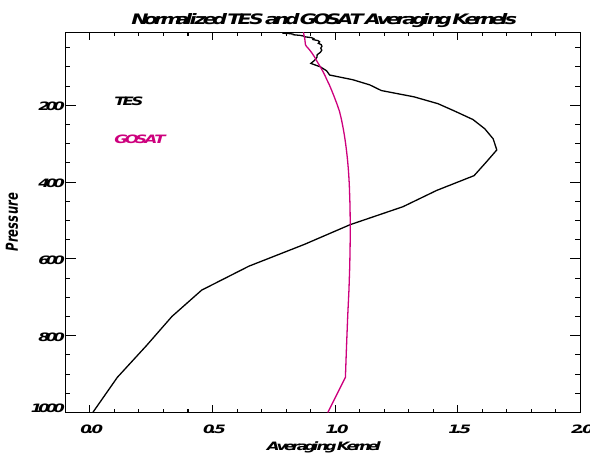
Figure 5. Sensitivity (or averaging kernel) of the total column with respect to the retrieved GOSAT and TES methane profile. Both av- eraging kernels have been normalized by the sub-column of each layer in the